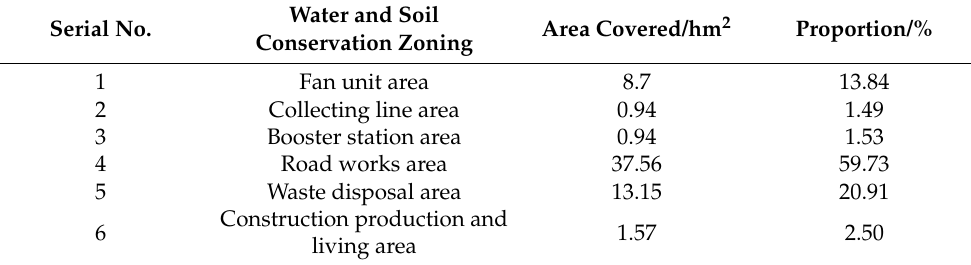
Table 5. Area and the proportion of water and soil conservation zones in the project area. Serial No.